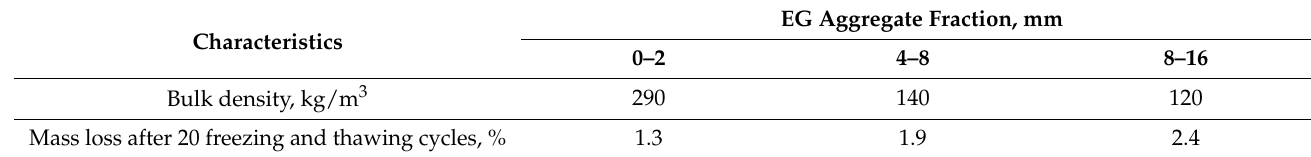
Table 5. Main characteristics of the EG aggregate.